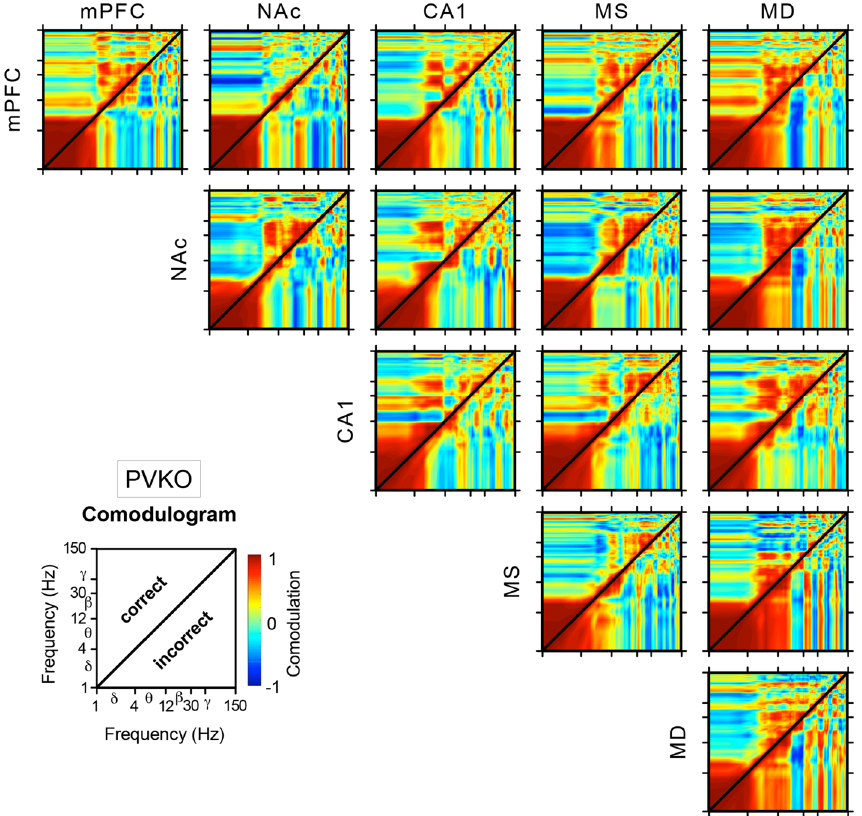
collected from mPFC, NAc, CA1, MS and MD of PVKO mice after correct (upper triangular map) and incorrect (lower triangular map) outcome of the operant task. Notice that non-symmetric patterns indicate that correctness of the trial outcome influenced the cross-frequency